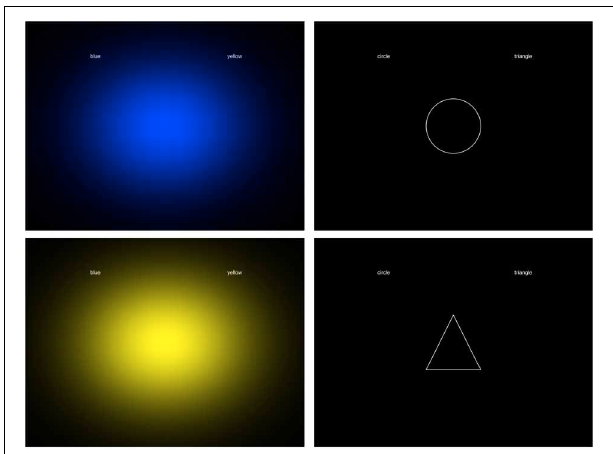
FIGURE 1 | Example stimuli used in the current